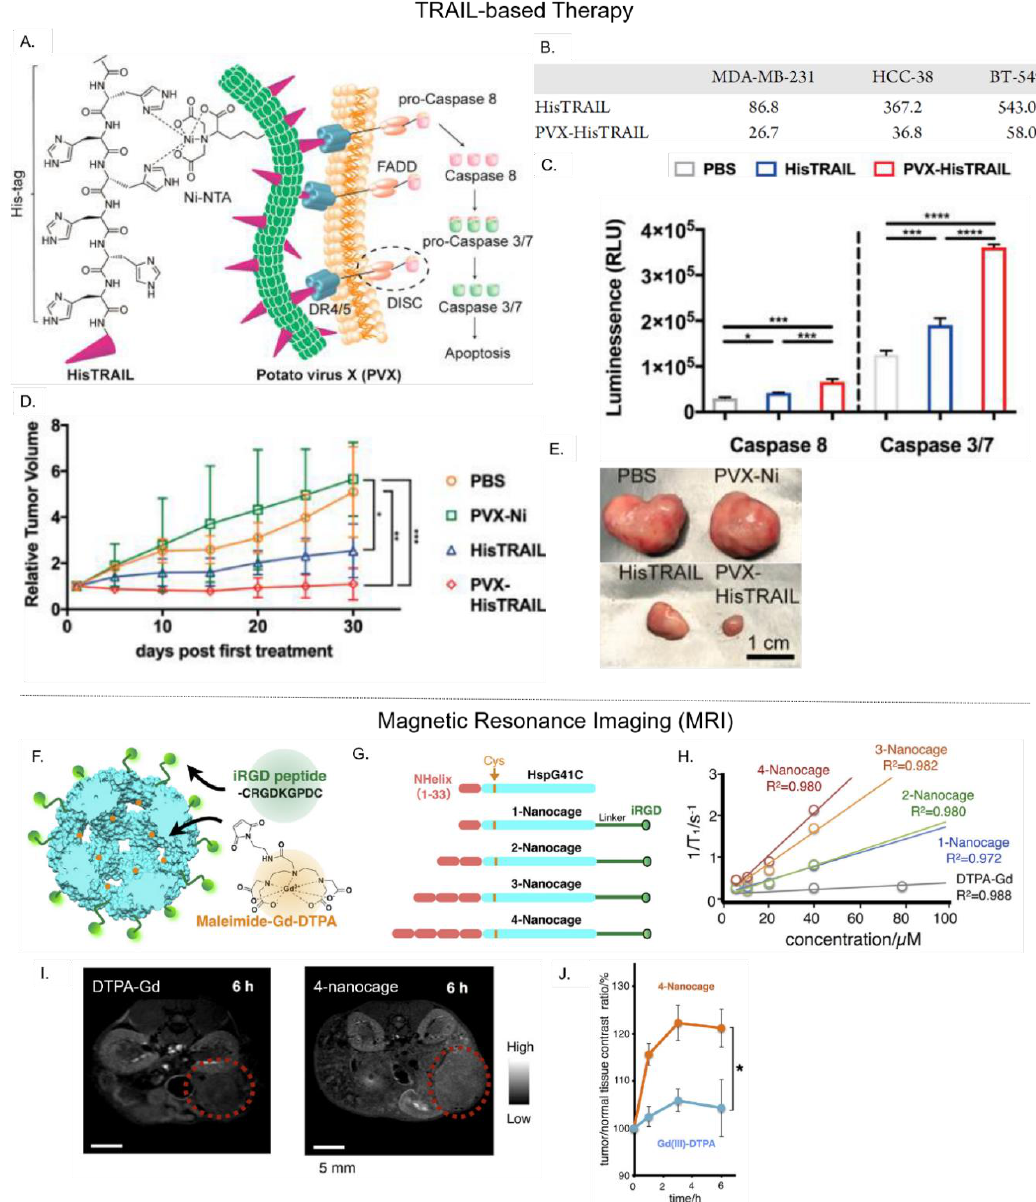
Figure 4. Examples of PNP-mediated delivery of biotherapeutics and imaging agents. ( Upper panel ) TRAIL-based therapy: PVX-mediated delivery of the anti-cancer biotherapeutic HisTRAIL. ( A ) Schematic showing PVX–HisTRAIL-induced apoptosis via caspase dependent pathway. ( B ) IC 50 of free His-TRAIL and PVX–HisTRAIL against various cancer cell types ( C ). PVX–HisTRAIL activated caspase 8 and caspase 3 / 7. ( D , E ) In comparison to free HisTRAIL, PVX–HisTRAIL significantly regressed tumor growth in tumor-bearing mice after 30 days. Adapted from [24], with permission from